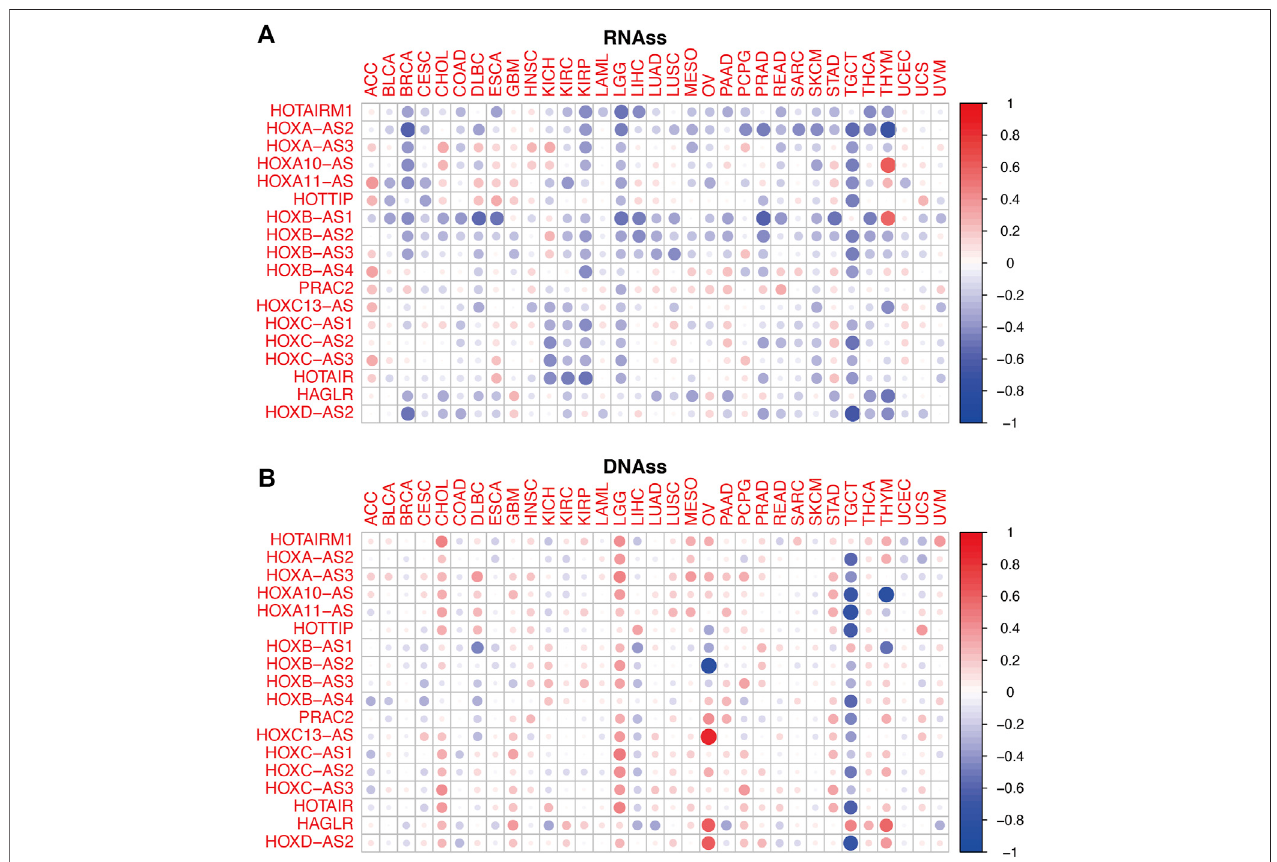
FIGURE 5 | Relationship between the homeobox antisense transcripts (HOXATs) expression levels and the tumor stemness. Correlation matrix of the HOXATs expression and the cancer RNA and DNA stemness scores, RNAss (A) and DNAss (B) , respectively, based on Spearman correlation tests.